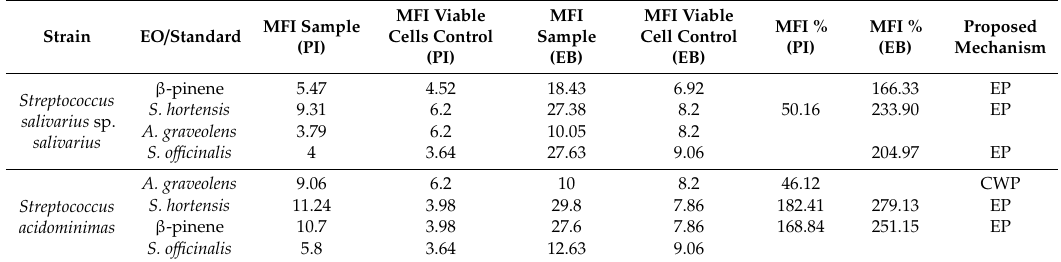
Table 2. Determination of the mechanisms of action of volatile oils and analytical standard β -pinene on the Streptococcus spp. by comparative analyses of the percentage increase in the median fluorescence intensity (MFI). PI: propidium iodide and EB: ethidium bromide, EP: e ffl ux pumps, CWP: cell wall